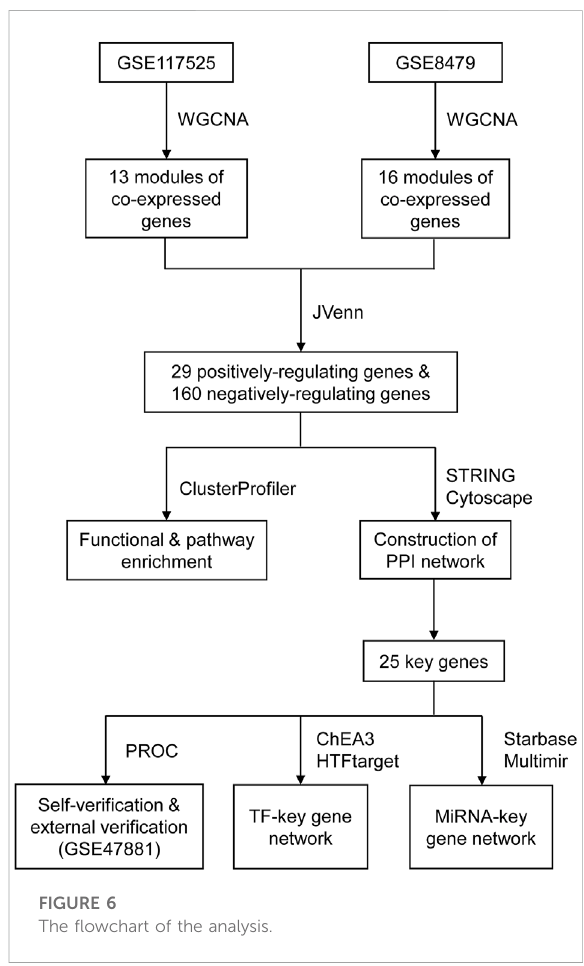
FIGURE 6 The fl owchart of the